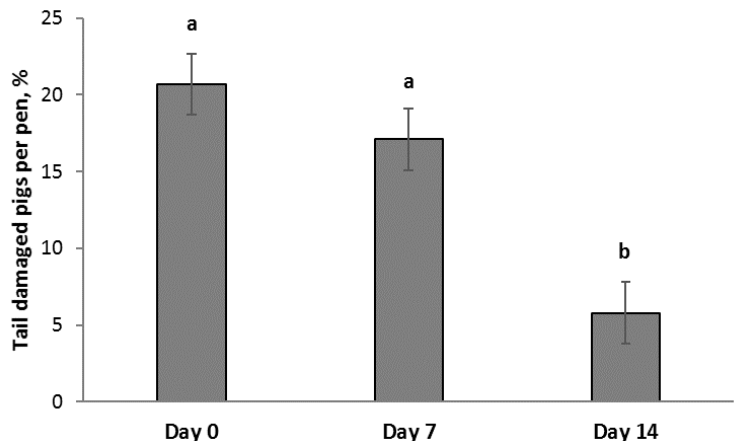
Figure 4. Percentage of tail damaged pigs per pen on day 0, day 7, and day 14 (LSmean ± SE) after the intervention in pens without an escalation in tail damage (n = 27). Different superscripts (a, b) indicate significant difference of p < 0.001.